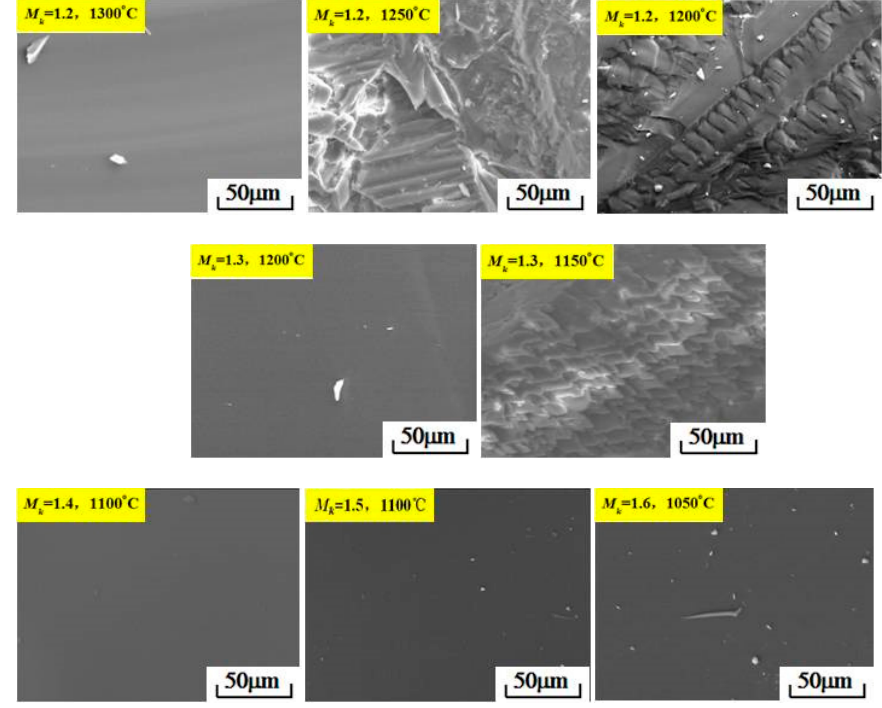
Figure 7. SEM images of the modified blast furnace slag with different M k values.